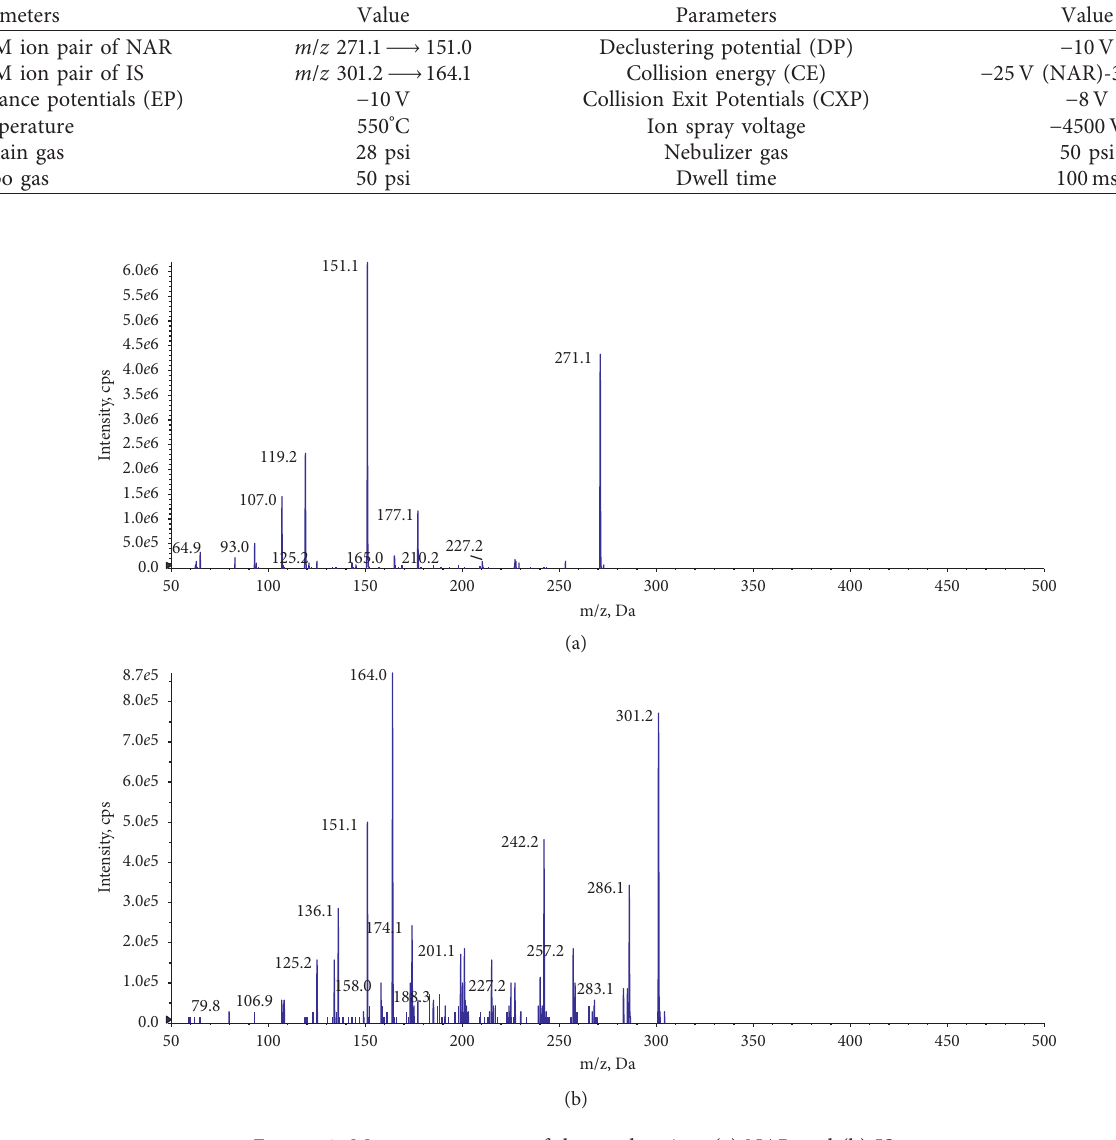
Figure 2: Mass spectrometry of the product ion: (a) NAR and (b)